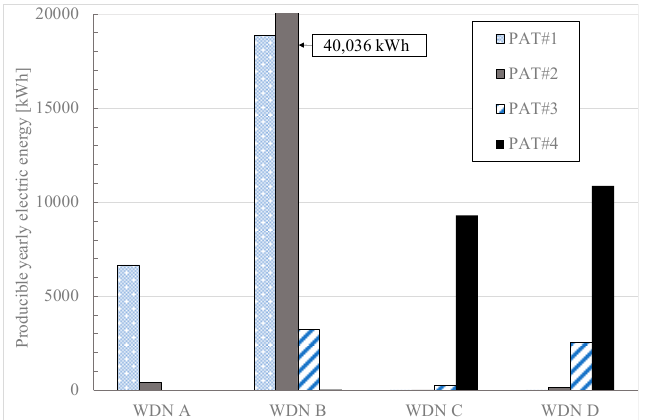
Figure 6. Producible yearly electric energy.